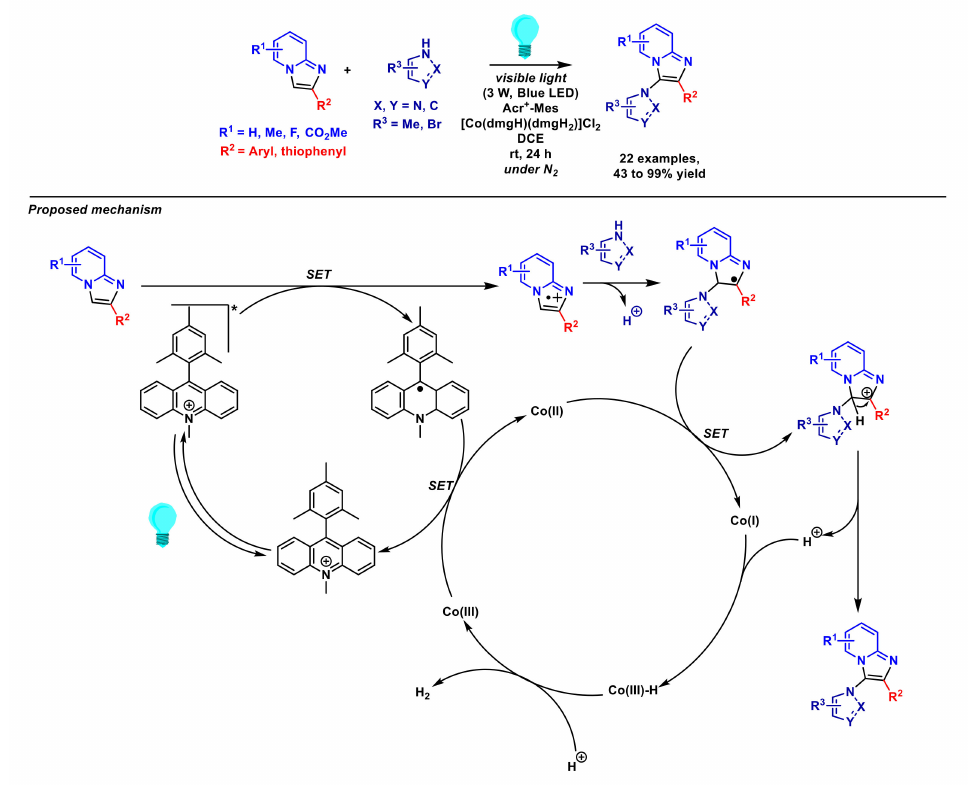
Similarly, Zhang and Lei introduced an azole motif in imidazo[1,2- a ]pyridines at position C 3 . In contrast with the previous method, the C–N bond formation additionally required a metal catalyst ([Co(dmgH)(dmgH 2 )]Cl 2, with dmg: dimethylglyoximato) [70]. The corresponding C 3 -functionalized imidazo[1,2- a ]pyridines were generated with good-to- excellent yields. The scope examination with azoles demonstrated good reaction tolerance by employing pyrazoles, imidazoles, or triazoles. A thorough mechanistic study, including the light on/off experiments, radical trapping, cyclic voltammetry measurements, and DFT (density functional theory) calculations, validated the radical reaction path. The excited state of the organophotocatalyst could allow for an SET to the imidazo[1,2- a ]pyridine. The generated radical cation species could then undergo a nucleophilic attack of the azole substrate, giving the corresponding radical. Simultaneously, a Co(III) catalyst could oxidize the reduced photocatalyst, releasing back the photocatalyst to its fundamental state. The subsequently formed Co(II) could realize an SET to the radical imidazo[1,2- a ]pyridine. The target aza-heterocycle could be engendered by deprotonation. Co(I) could be converted back into Co(III) by proton capture and dehydrogenation (Scheme